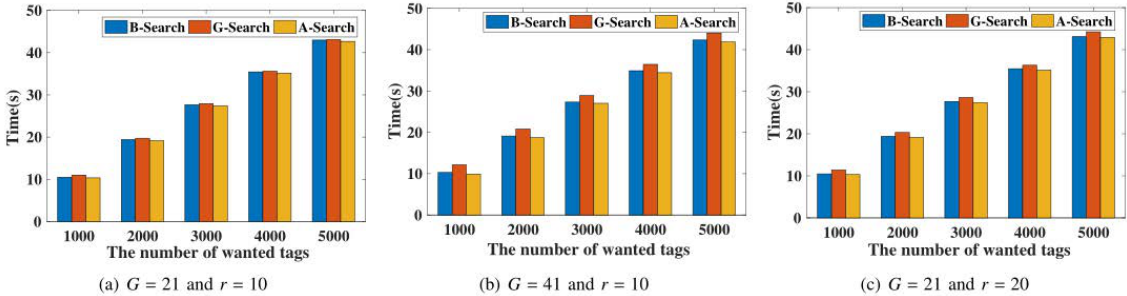
Figure 6. The time efficiency of each protocol under different numbers of wanted